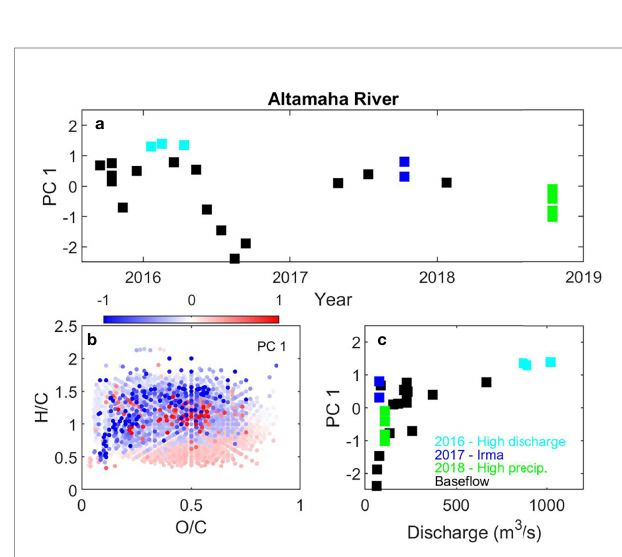
FIGURE 7 | Principal component analysis of DOM composition at the Altamaha River. (A) Scores of the fi rst principal component. (B) van Krevelen diagram color coded with loadings of PC 1 (colorbar shown on top of panel B ). (C) Scores of PC 1 plotted against Altamaha River discharge.